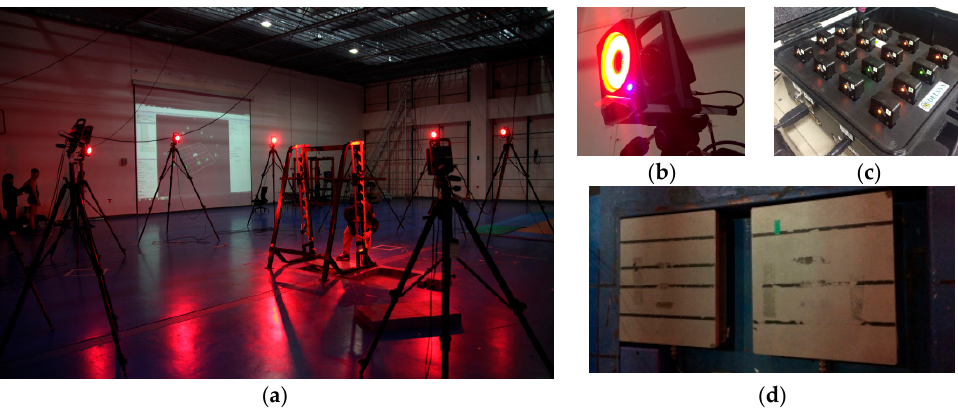
Figure 2. Experimental apparatus: ( a ) motion capture studio at the Advanced Institute of Convergence Technology; ( b ) Vicon T-120 camera; ( c ) Delsys Trigno wireless EMG sensors; and ( d ) AMTI OR6-7 force plate.